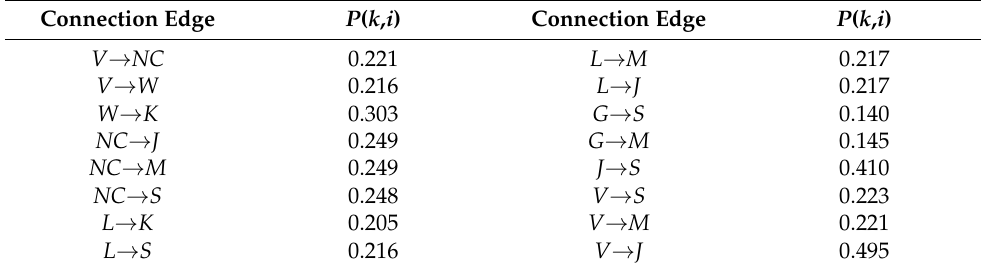
Table 12. Importance of each connection edge of machining center.